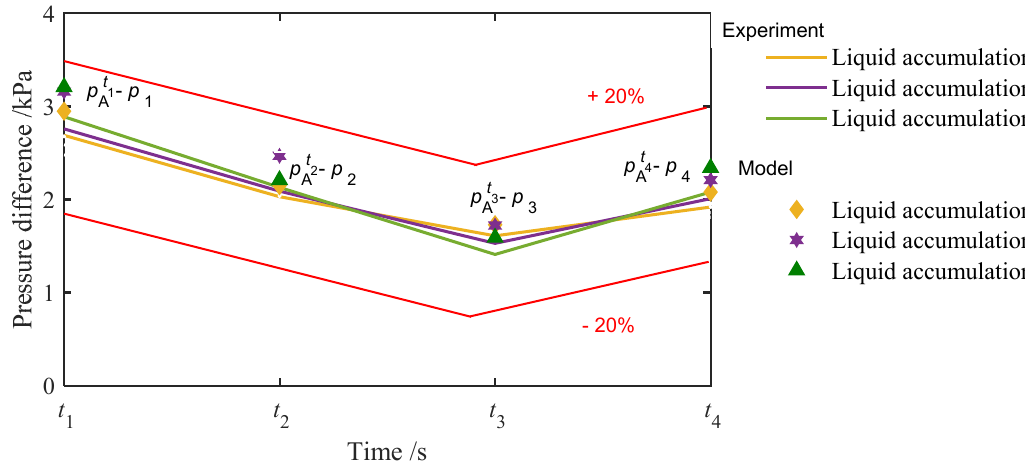
Figure 11. Verification of slug flow pressure model with an inclination of 15°.